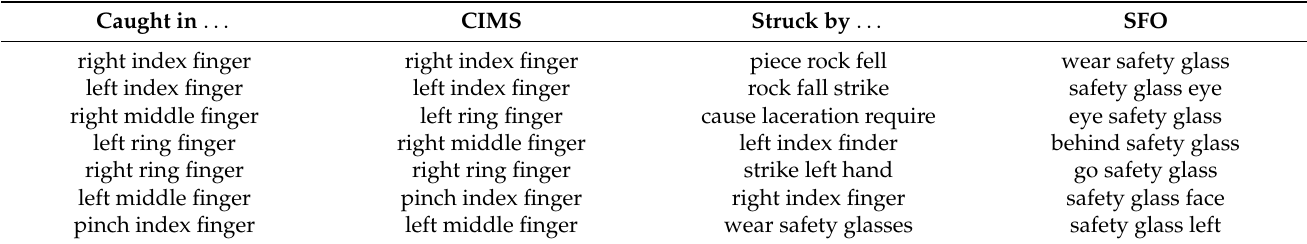
Table 6. Results of trigram analysis on Caught in and Struck by accident types. Caught in . . .